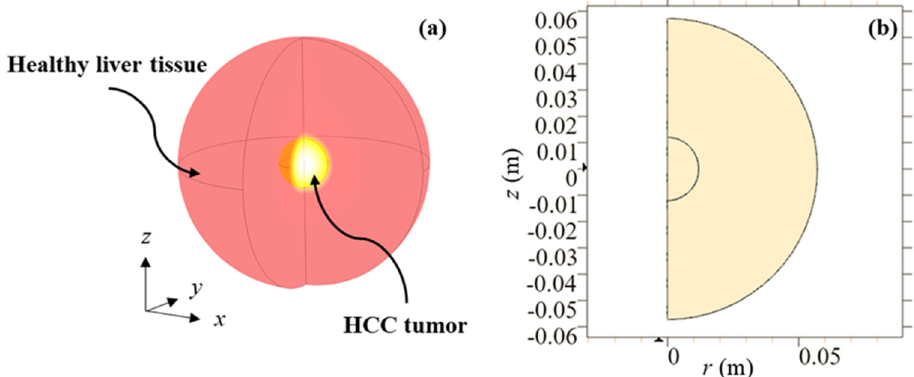
Figure 1. Physical domain ( a ) and computational domain ( b ) of the problem. The internal and the external spheres represent the HCC tumor and the healthy liver tissue respectively.